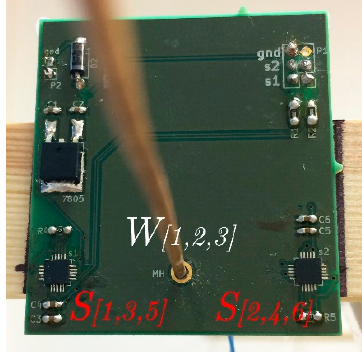
Figure 3. Detail of sensor PCB with a pair of